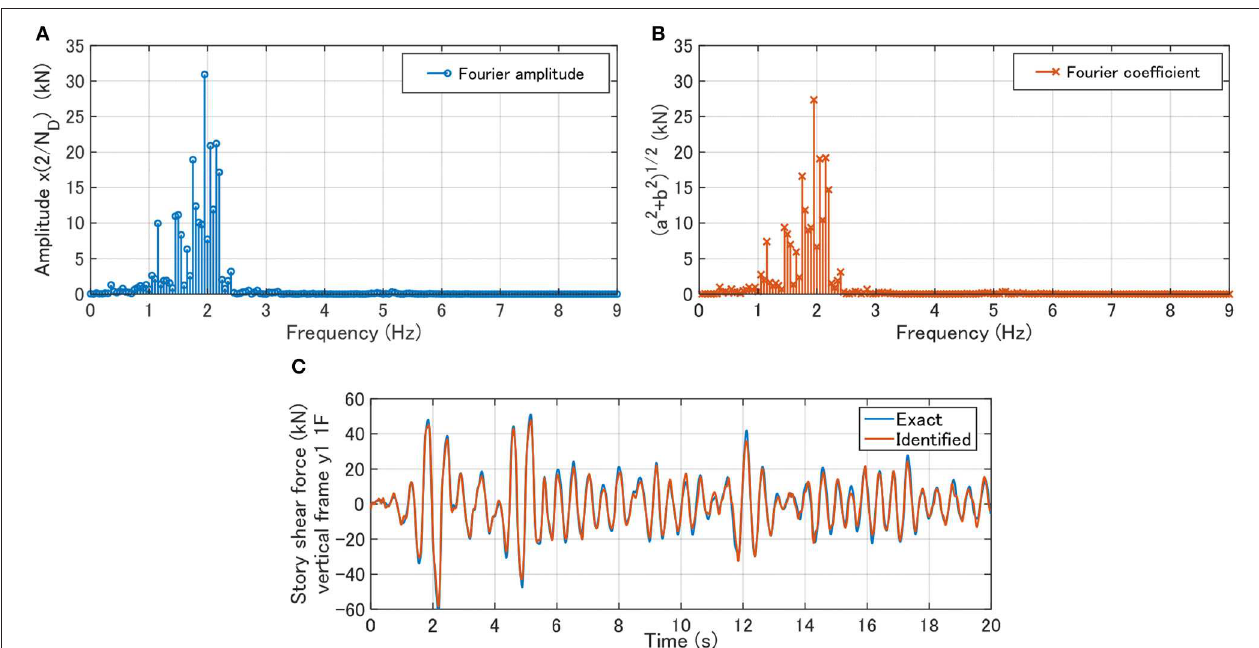
FIGURE 8 | Verification of proposed method for story shear force Q [ y 1] Wx 1 of y 1 frame in the first story. (A) Fourier amplitude spectrum divided by half of number of data